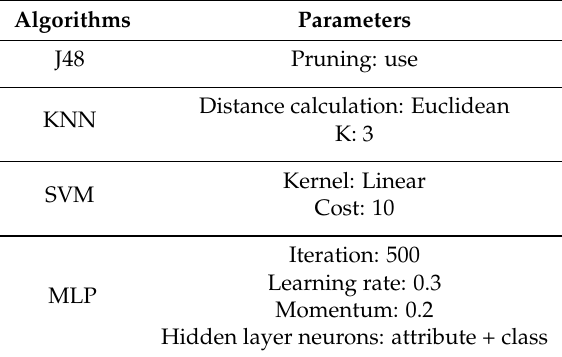
Table 6. Test adjustable